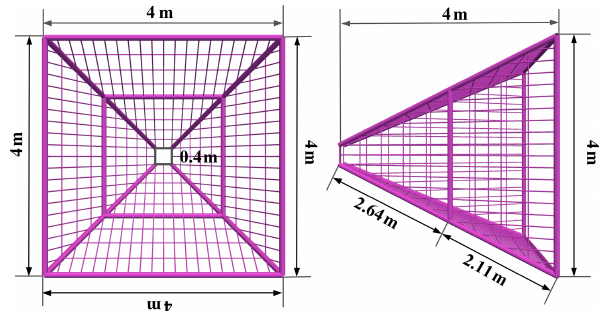
Figure 3. Configuration of SITNCS.